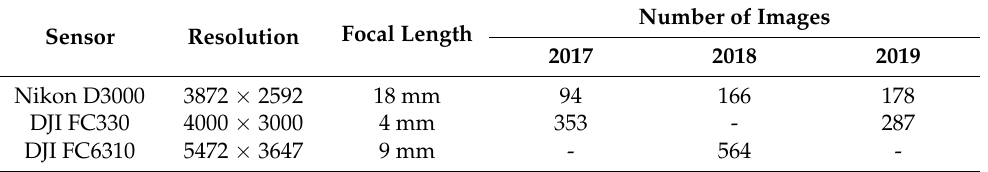
Table 2. Overview of sensors and